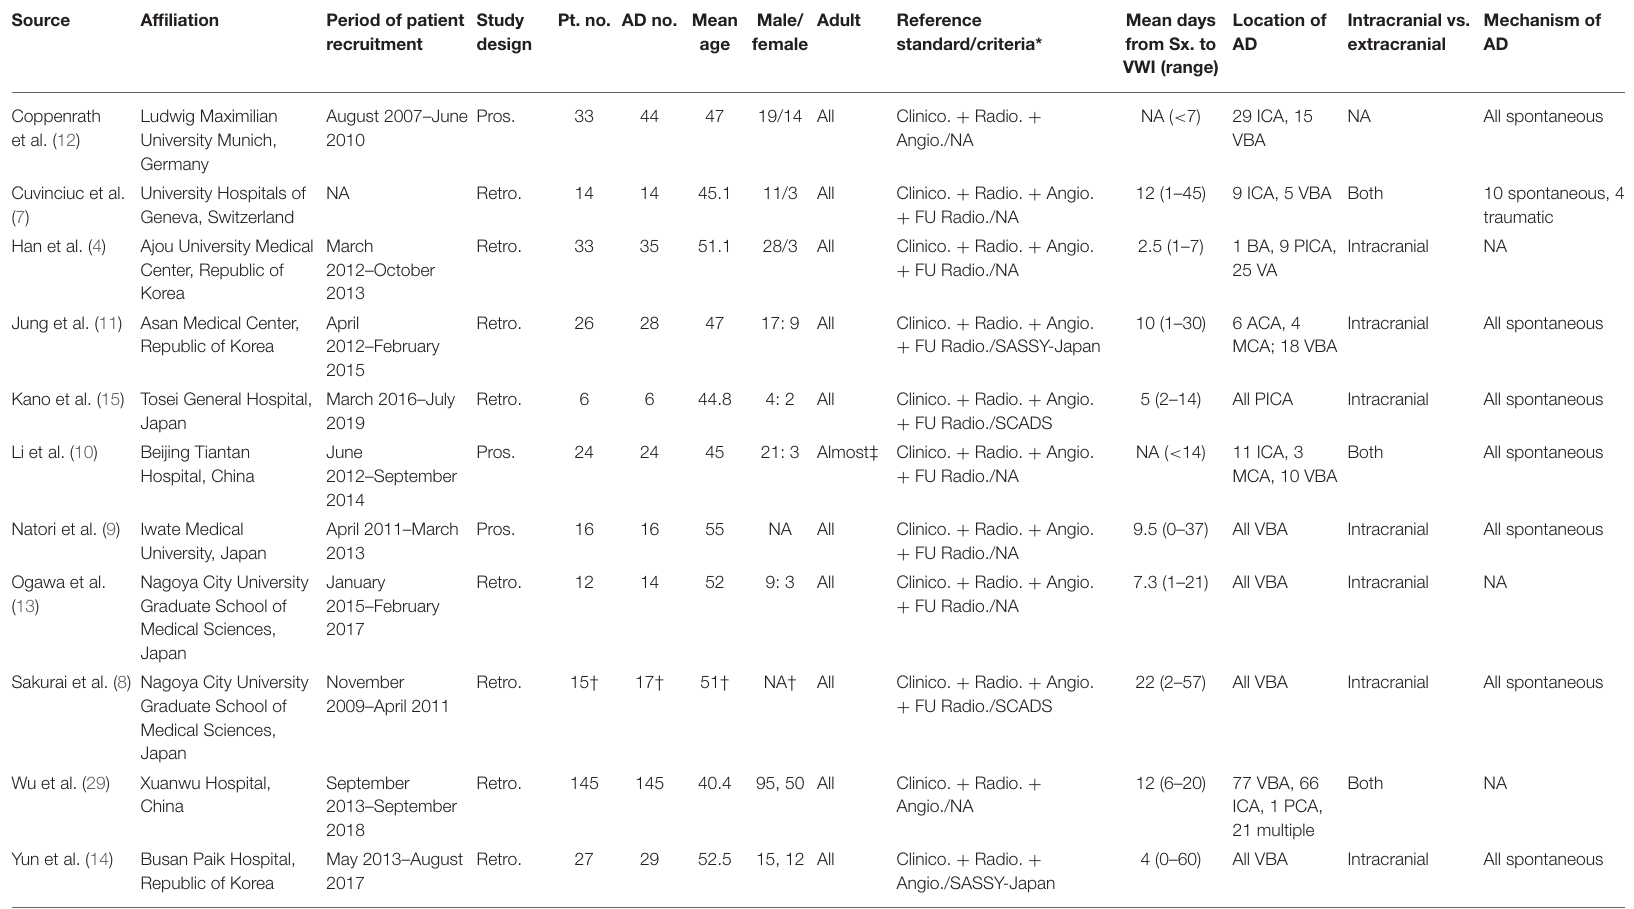
TABLE 1 | Characteristics of the included